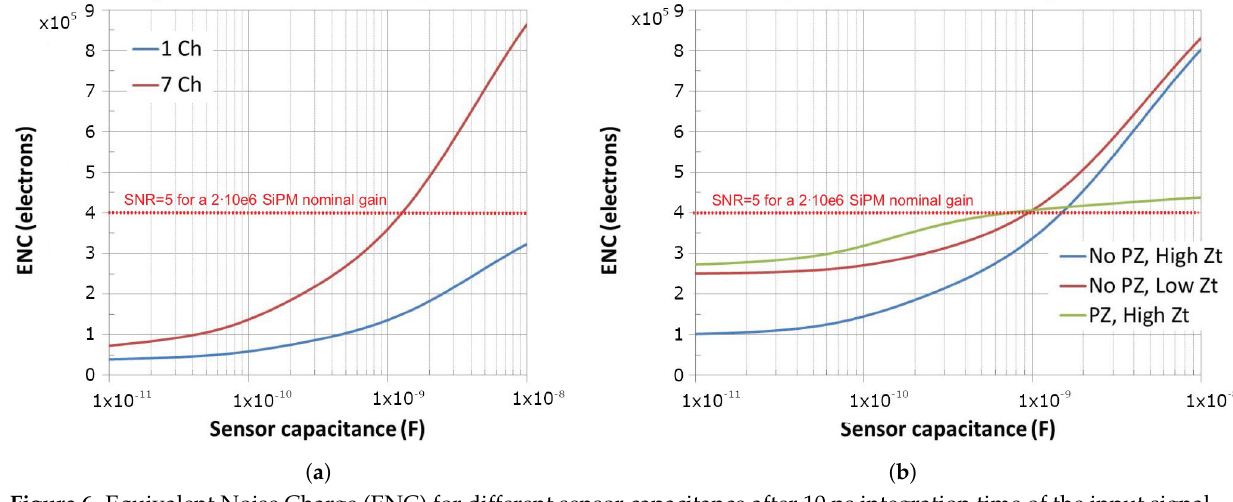
Figure 6. Equivalent Noise Charge (ENC) for different sensor capacitance after 10 ns integration time of the input signal. ( a ) Summation of the HG differential output for 1 and 7 channels. ( b ) Individual analog single ended response with and without PZ filter and using the high and low trans-impedance (Zt) gains.